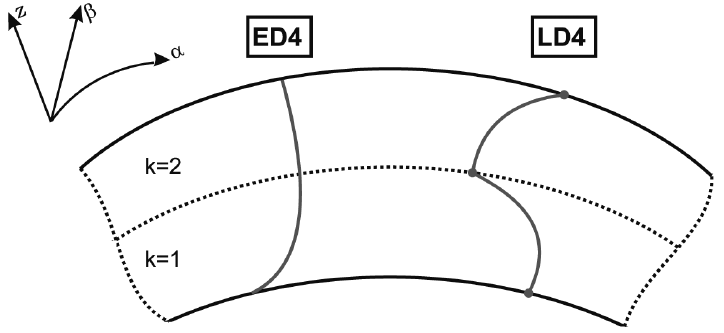
Fig. 1. Equivalent single layer and layer wise theories for a two-layered